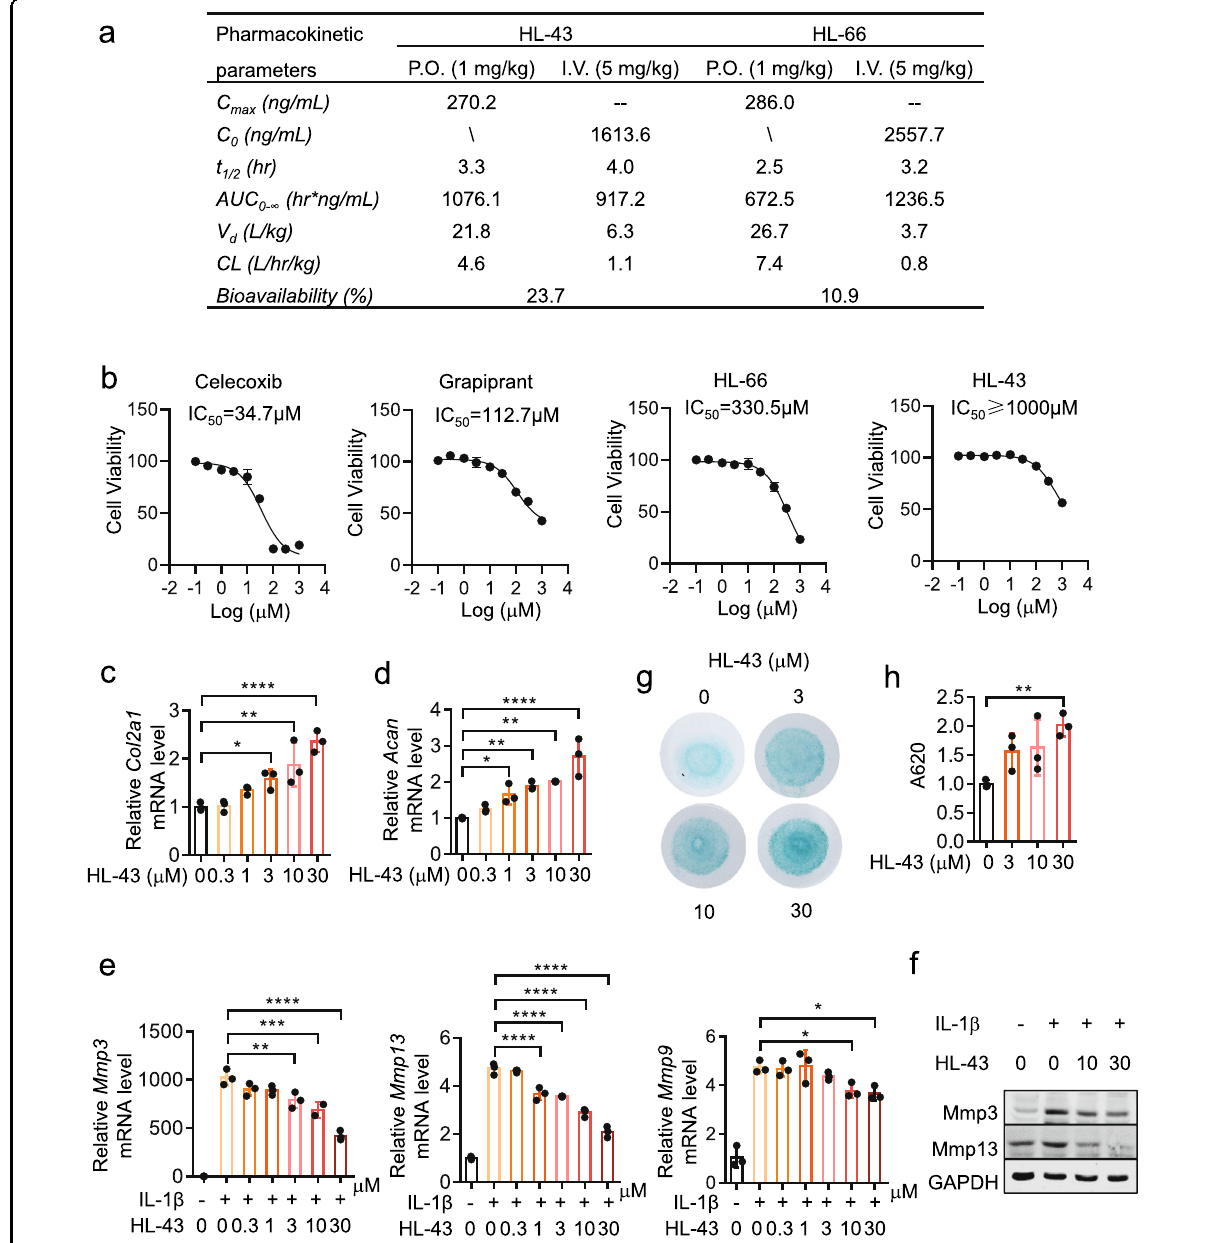
Fig. 4 Identi fi cation of a novel EP4 antagonist HL-43 for promoting chondrocyte differentiation and anabolism with low toxicity and desirable bioavailability. a Pharmacokinetic parameters of HL-66 and HL-43 after oral (P.O.) administration or intravenous (I.V.) injection in CD1 mice. b Primary articular chondrocytes were treated with Celecoxib, Grapiprant, HL-66, and HL-43 for 72 h. Cell viability was assessed using CCK-8 assay and IC 50 values were calculated respectively. Error bars are means ± s.d., n = 3. c , d qRT-PCR analysis of anabolic factors Col2a1 ( c ), Acan ( d ) expressed in primary articular chondrocytes treated with indicated concentrations of HL-43 for 24 h. Error bars are means ± s.d., n = 3. * P < 0.05, ** P < 0.01, *** P < 0.001, **** P < 0.0001 by one-way ANOVA with multiple comparison using Tukey method. e qRT-PCR analysis of catabolic factors Mmp3, Mmp13 , Mmp9 expressed in primary articular chondrocytes treated with 1 ng/ml IL-1 β and indicated concentrations of HL-43 for 24 h. Error bars are means ± s.d., n = 3. * P < 0.05, ** P < 0.01, *** P < 0.001, **** P < 0.0001 by one-way ANOVA with multiple comparison using Tukey method. f Western blotting analysis of catabolic factors Mmp3 and Mmp13 expressed in primary articular chondrocytes treated with 1 ng/ml IL-1 β and indicated concentrations of HL-43 for 24 h. g , h HL-43 induced chondrocyte differentiation in a dose-dependent manner. Micromass of the chondrocytes cultured in the chondrogenic media for 7 days and stained with Alcian blue ( e ). Alcian blue-stained cultures were quanti fi ed ( f ). Error bars are means ± s.d., n = 3. * P < 0.05, ** P < 0.01, *** P < 0.001, **** P < 0.0001 by one-way ANOVA with multiple comparison using Tukey